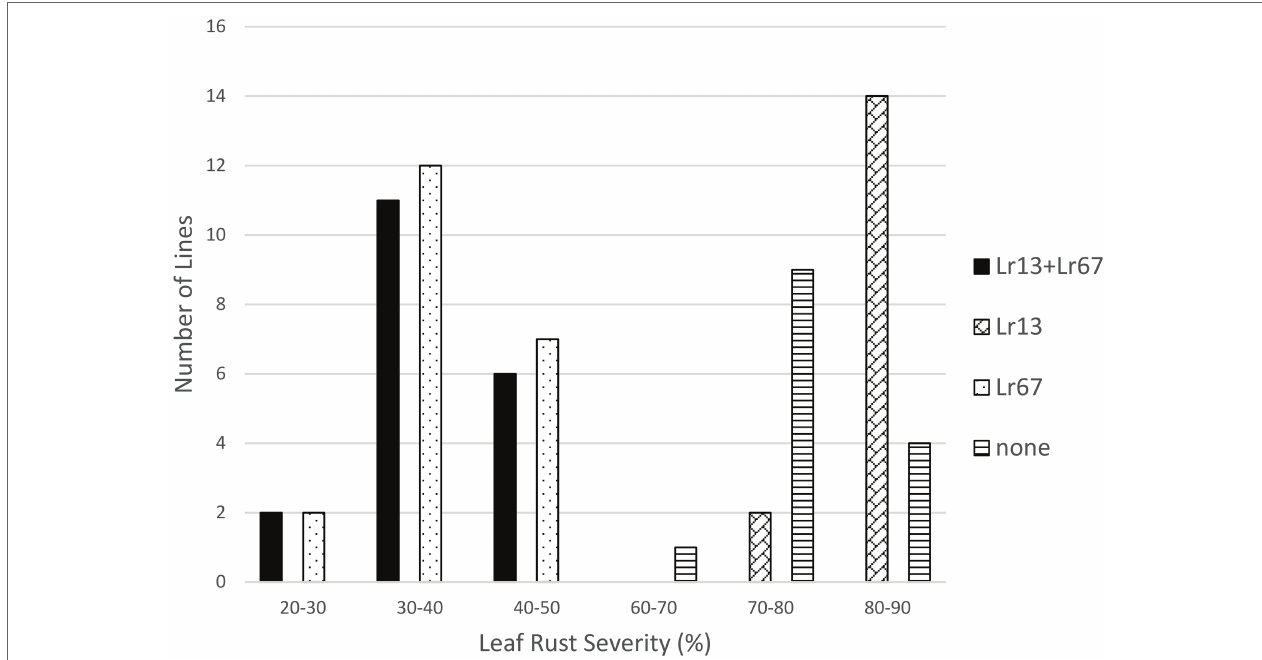
FIGURE 2 | Average leaf rust field severity (2012–2017) for progeny lines from the cross Lr13 / Lr67.